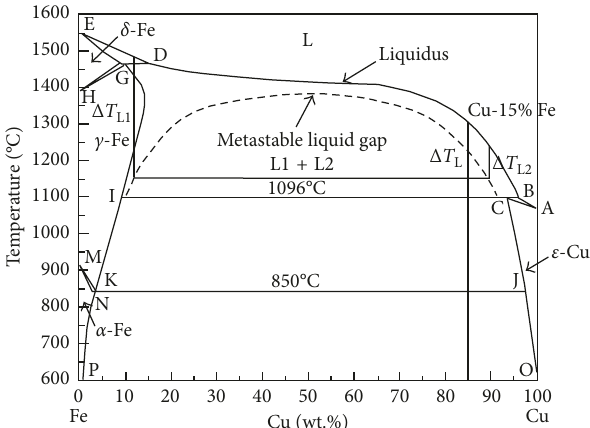
Figure 1: Phase diagram of the Cu-Fe binary alloy with the metastable miscibility gap [2].